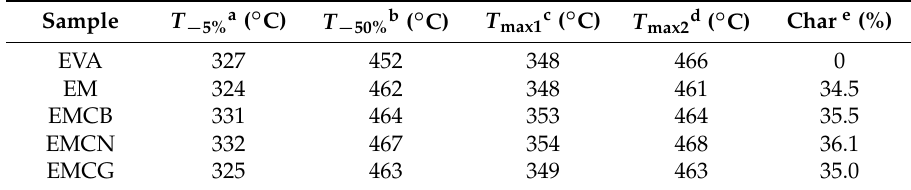
Figure 2. ( a ) TGA and ( b ) DTG curves of pure EVA and its composites at a heating rate of 10 °C/min in nitrogen. Table 2. TGA and DTG data of pure EVA and its composites in